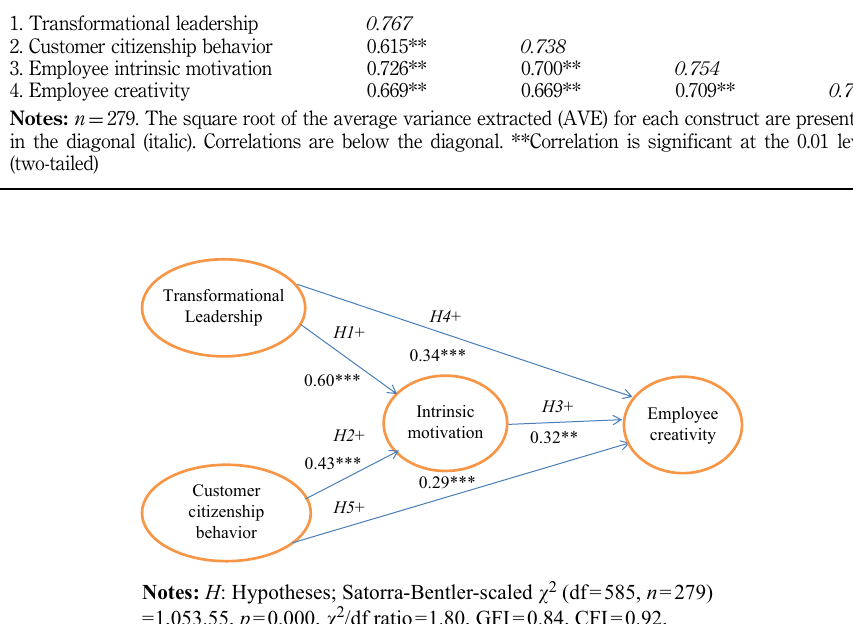
coefficients of the path analysis